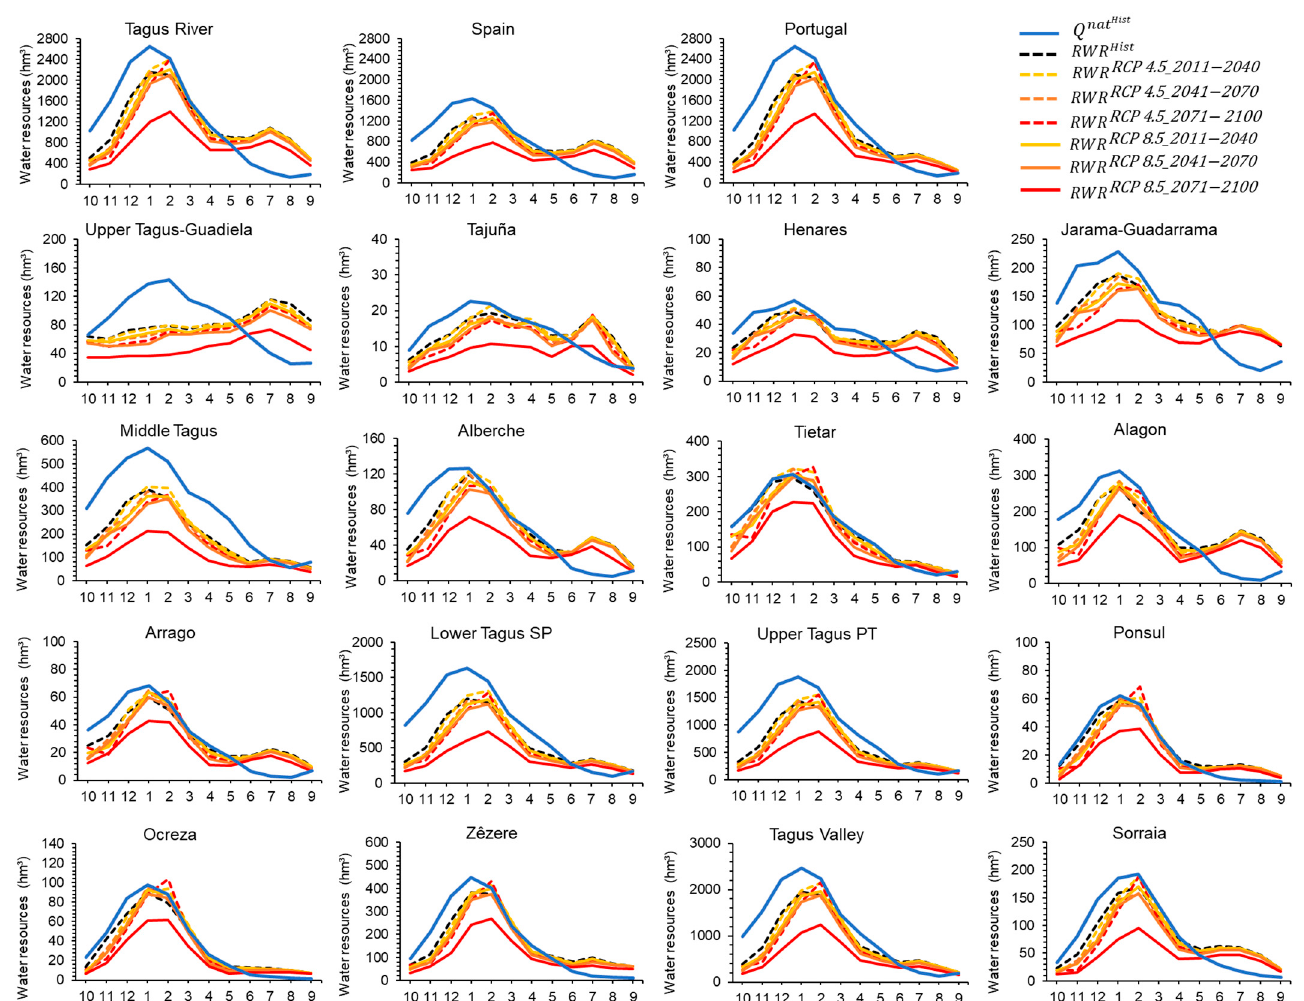
Figure 2. The average monthly streamflow under historical records (blue line) and the average monthly available water resources of sub-basins, Spain and Portugal, and the entire Tagus River basin for near, mid and far-future horizons under RCP 4.5 and 8.5.